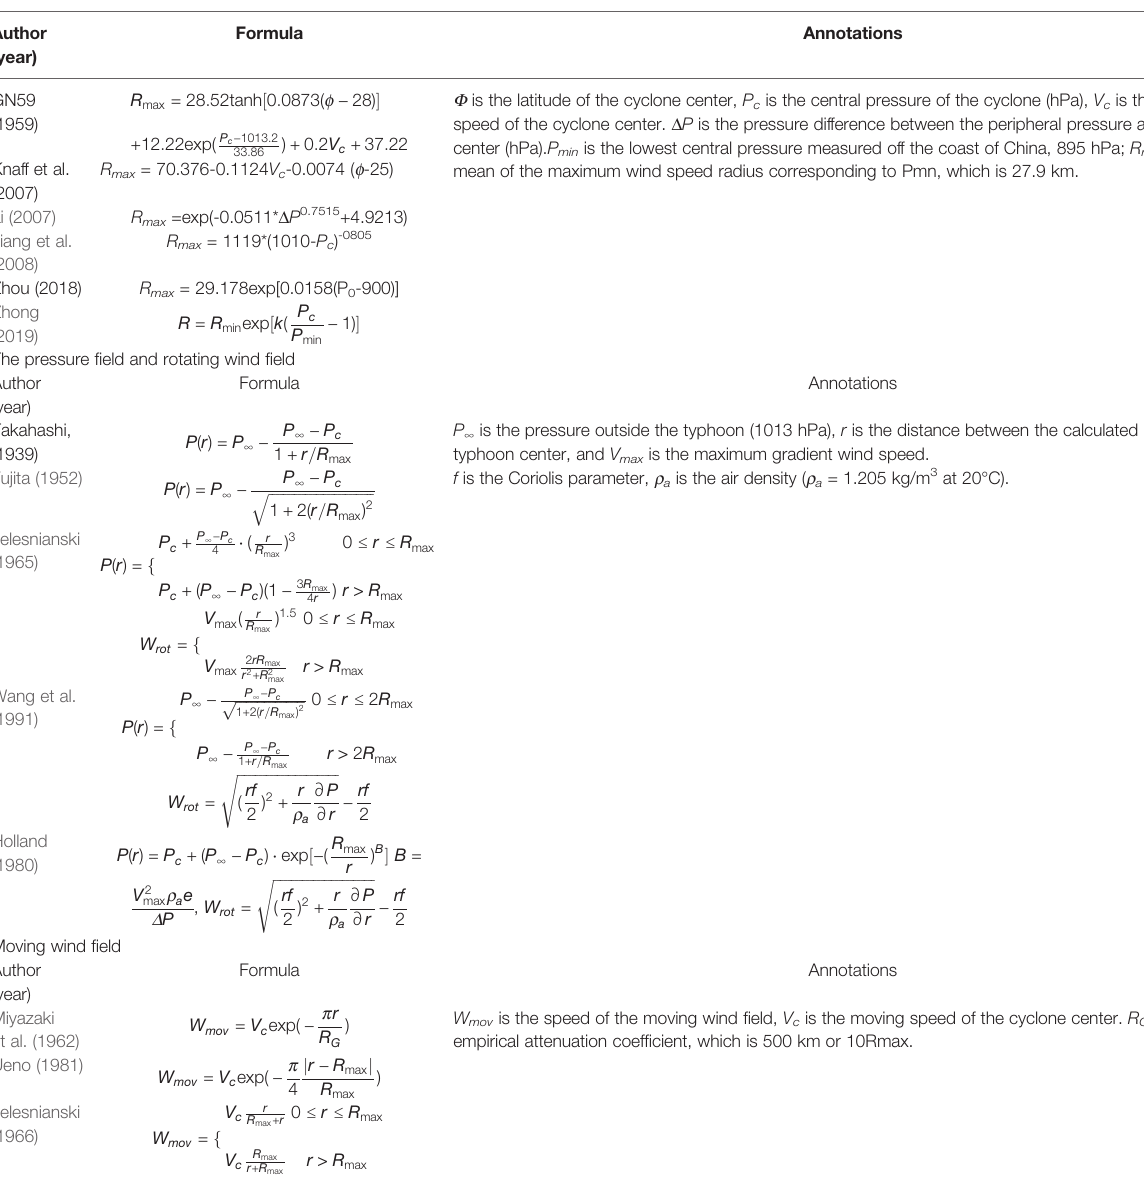
TABLE 1 | Related research on the wind fi eld